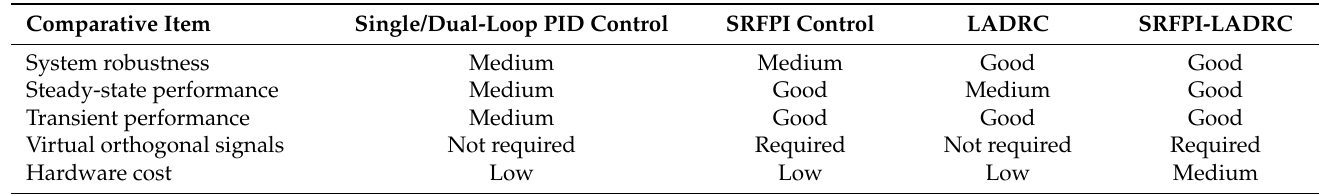
Table 1. Feature comparison of single-phase inverters with different control